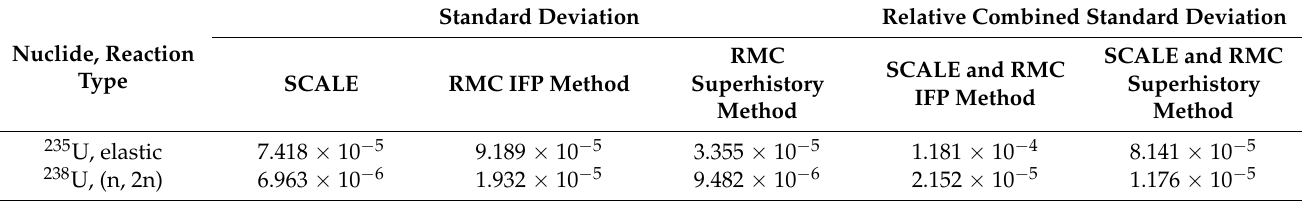
Table 5. Standard deviation of some nuclides reaction